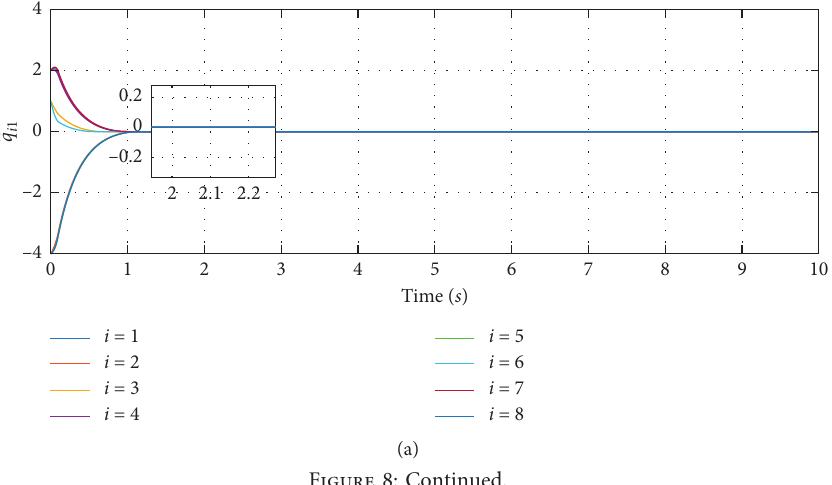
i for links 1 and 2.